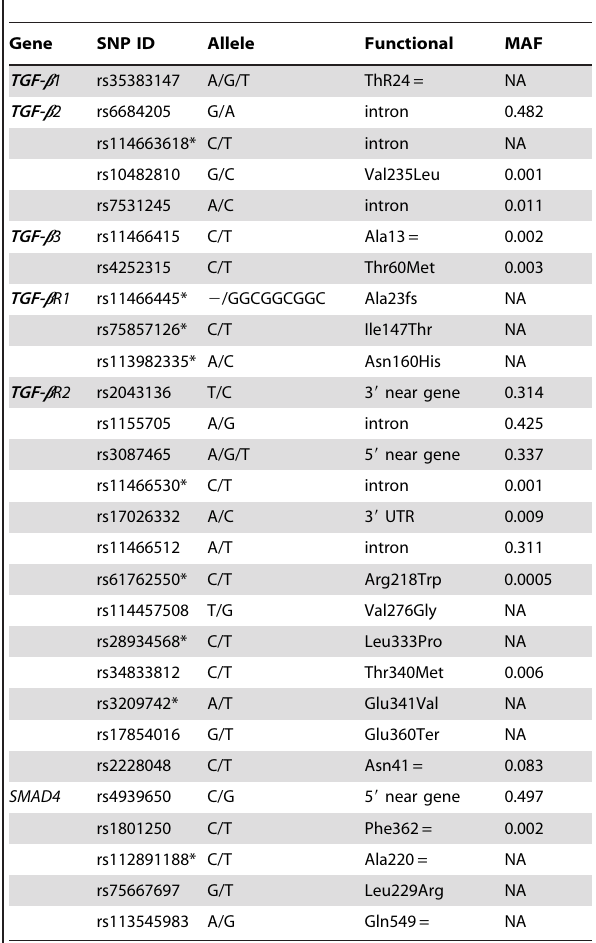
Table 5 . Genotype frequency and median survival